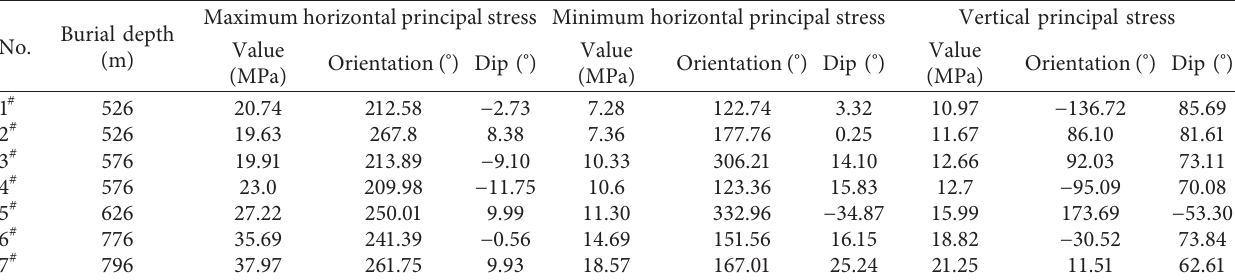
Table 3: Calculation results of principal stress at each measuring point.